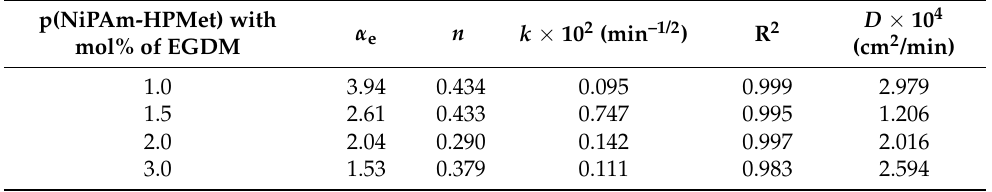
Table 4. The equilibrium swelling ratio ( α e ) and kinetic parameters ( n , k and D ) of the fluid diffusion into p(NiPAm-HPMet) hydrogels at 40 ◦